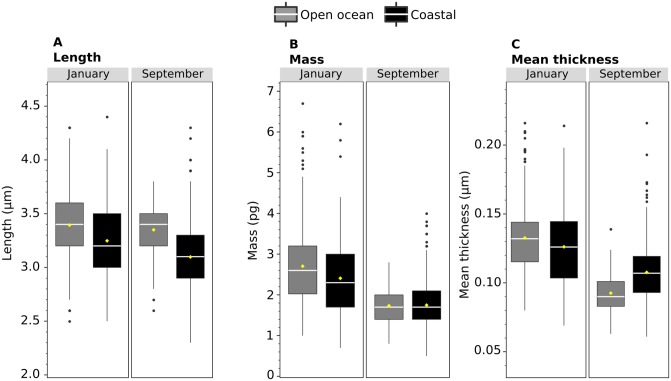
Boxplots showing length, mass, and thickness of E. huxleyi coccoliths measured on the light microscope.January represents samples from 10m at EBC (coastal) and 15m at LP (offshore) during METEOR cruise 37/2b, while September measurements represent samples from 75m at EBC (coastal) and 10m at LP (offshore). A: length. B: mass. C: mean thickness per coccolith. Horizontal white lines indicate the median, while yellow diamonds are the average values for each sample. Black dots represent outliers (values greater than 1.5 times the interquartile range).